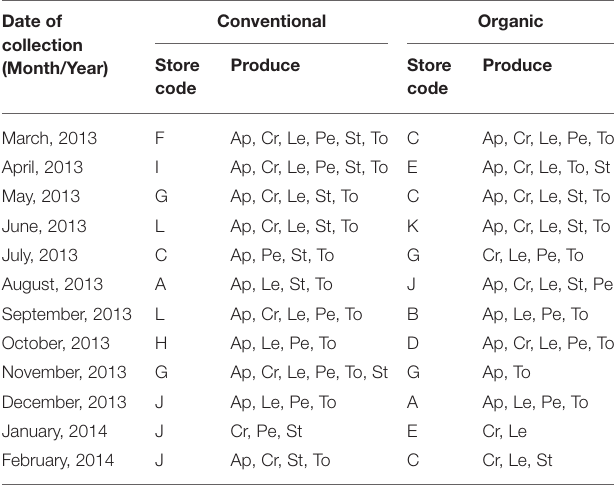
TABLE 1 | Distribution of 144 samples (70 fruits and 74 vegetables) according with date of collection, store, and